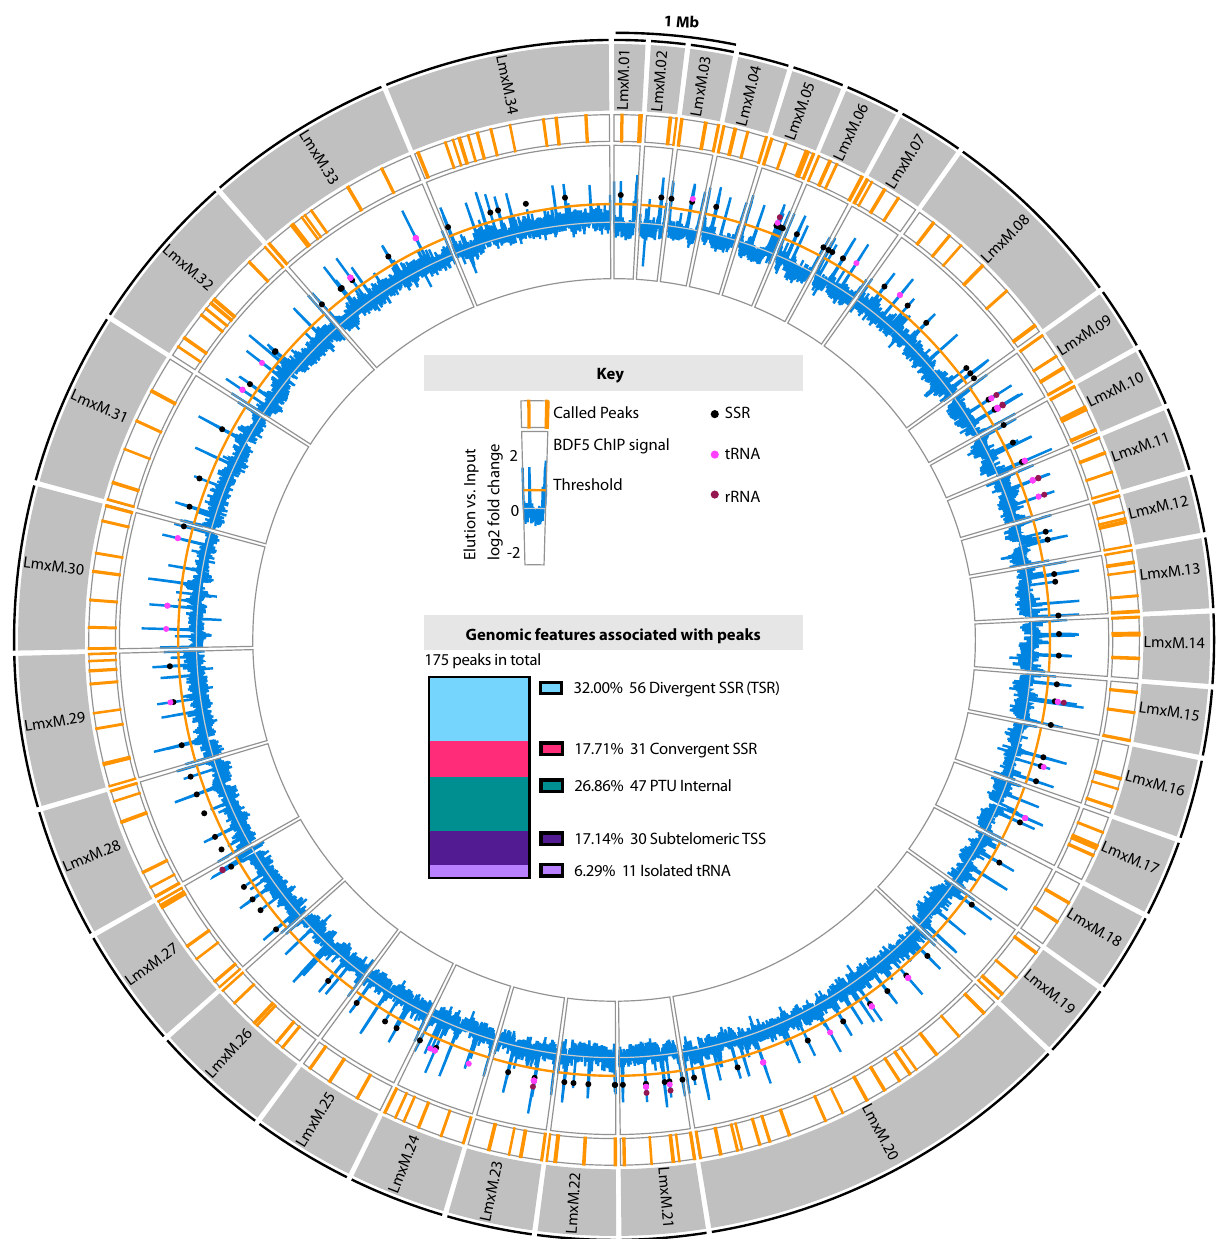
Fig. 3 Genome-wide distribution of BDF5 determined by ChIP-seq analysis. Outer circles: Circos plot representing the 32 MB L. mexicana genome. The 34 chromosomes are depicted by grey segments. Inner circles represent results from BDF5 ChIP-seq. Formaldehyde-crosslinked, enzymatically fragmented chromatin from the BDF5::6xHA − / + fl x strain was immunoprecipitated using anti-HA, reverse crosslinked and Illumina sequenced. Regions enriched >0.5 log2fold for BDF5 are indicated by the orange bars, the enrichment of BDF5::6xHA in the elution over the input chromatin is indicated in the blue line on a log2 fold scale, values are the mean derived from 3 ChIP replicates. Genomic features such as strand-switch regions (SSR), tRNA genes, and rRNA genes are indicated by coloured circles on this blue line. Inner panel: Key and stacked bar chart showing the genomic features associated with the